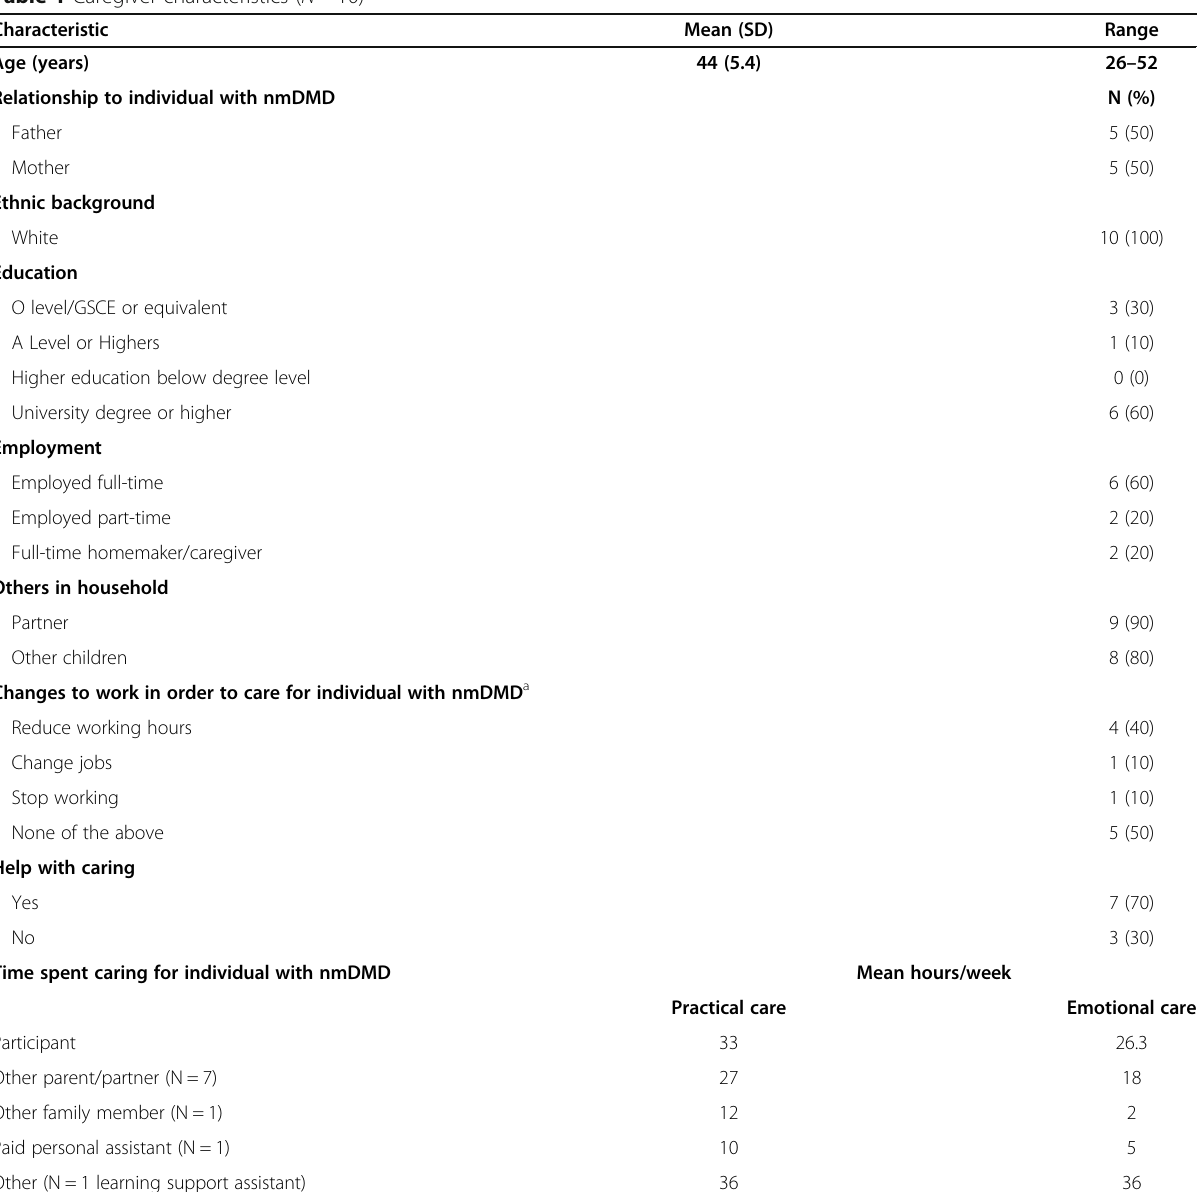
Table 1 Caregiver characteristics ( N = 10) Characteristic Mean